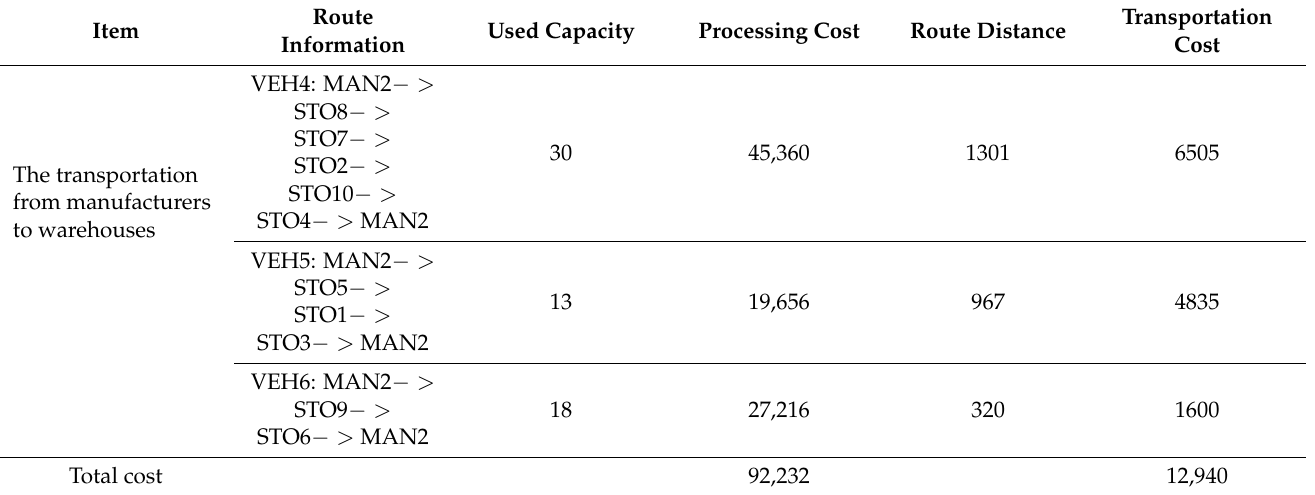
Table 10. The transportation from manufacturers to warehouses in the optimal solution of P01 by HCDBAVNS.